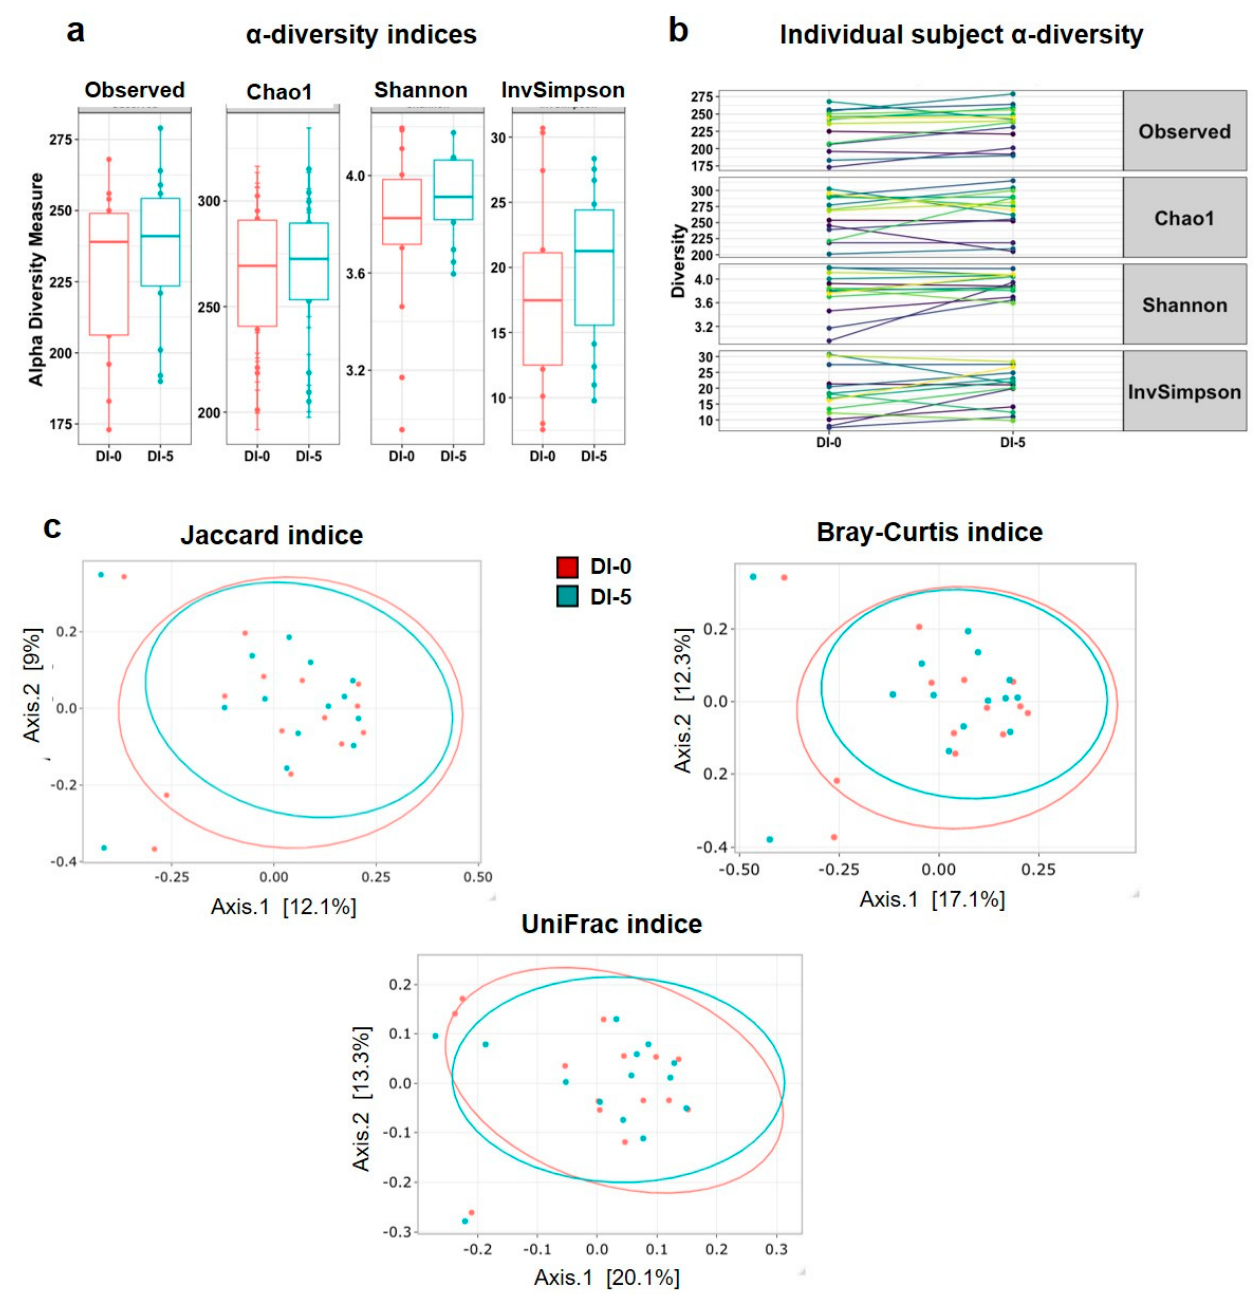
Figure 3. α and β diversity indices before (DI-0) and after 5 days of Dry Immersion (DI-5) in healthy men ( n = 14). ( a ) α -diversity evaluated with the Observed, Chao1, Shannon and InvSimpson indices. The paired t -test did not find any significant difference between time points. ( b ) Individual α -diversity evaluated with the Observed, Chao1, Shannon and InvSimpson indices. ( c ) β -diversity analysis using the Jaccard ( p = 0.998), Bray–Curtis ( p = 0.997) and UniFrac ( p = 0.999) indices indicated no difference between DI-0 and DI-5 in microbial OTU absence/presence, abundance, or phylogeny (PERMANOVA analysis). Data are mean ± SEM.